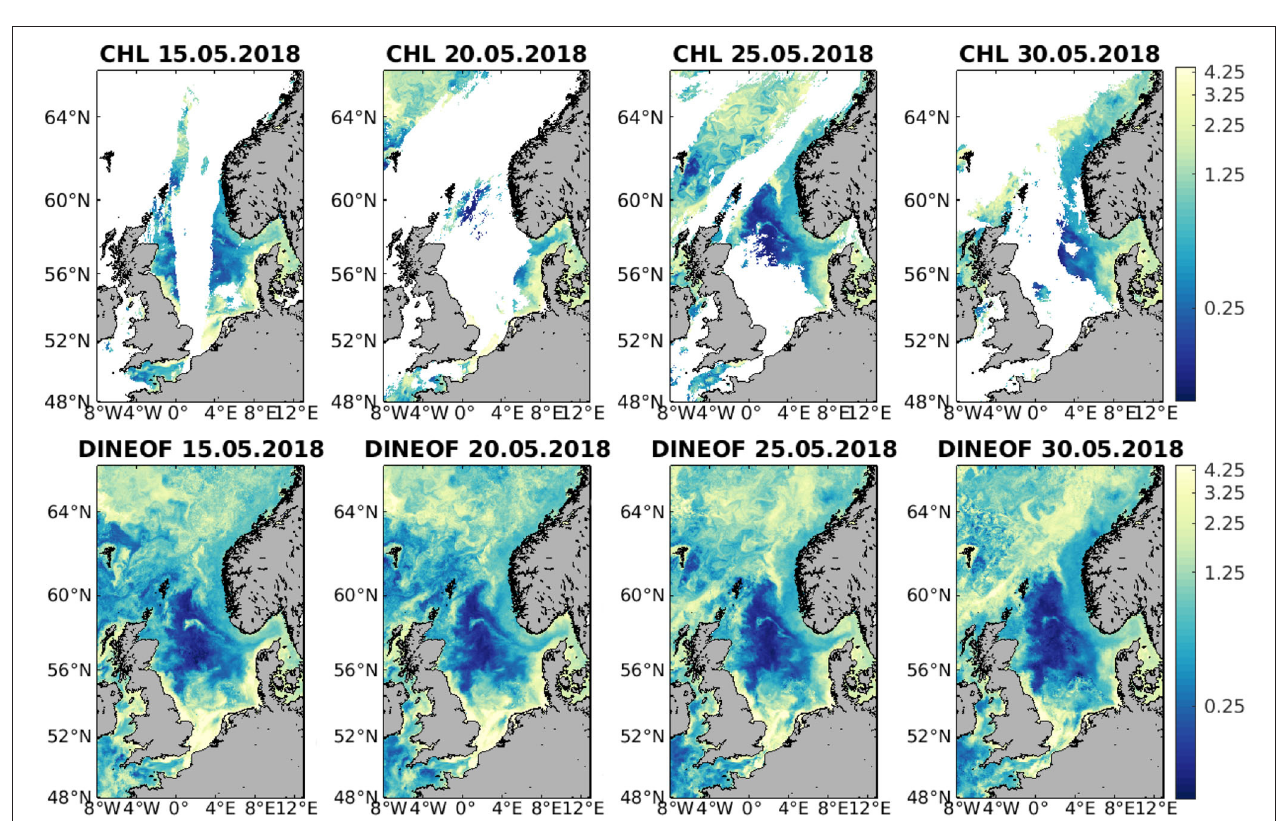
FIGURE 4 | Example of CHL ( µ g / l ) on 15, 20, 25, and 30 May 2018 for the initial data (top) and corresponding DINEOF reconstruction (bottom) .